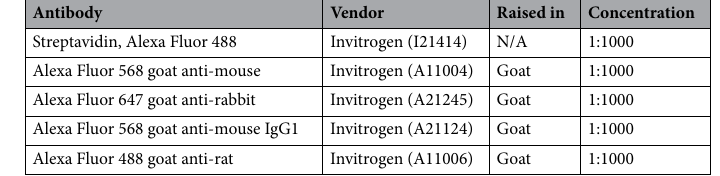
Table 2. Secondary antibodies. All primary antibodies were made in the corresponding blocking/ permeabilization buffer.